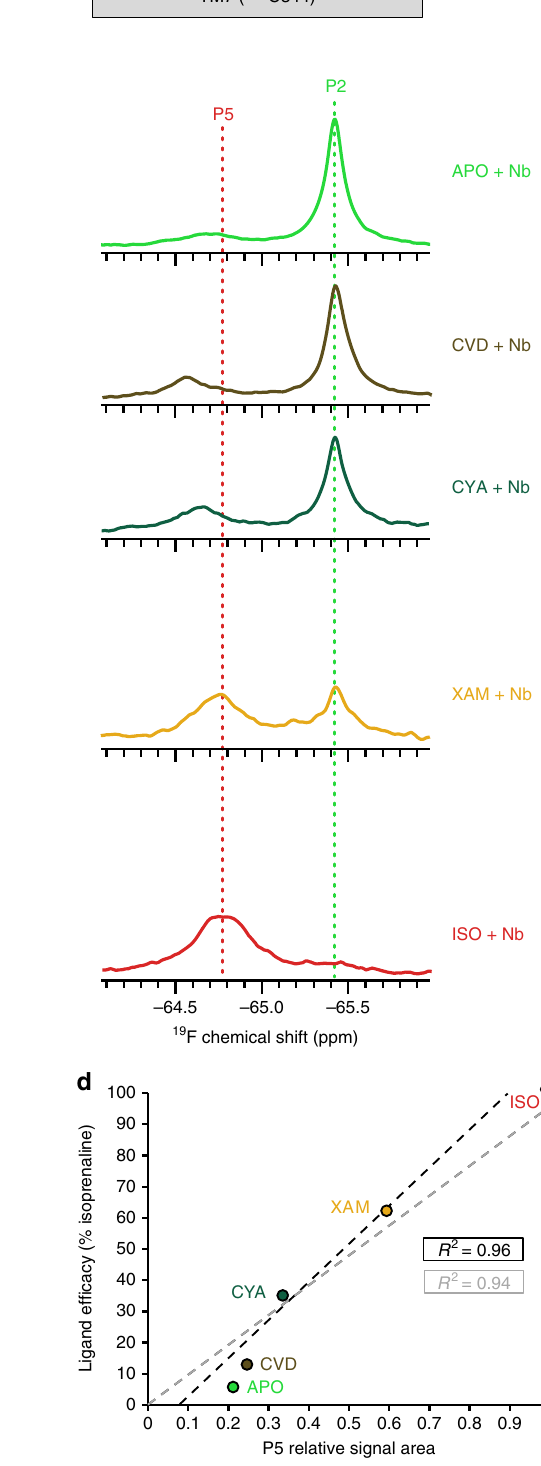
Probing the receptor with a range of agonists varying in ef fi - cacy revealed that the P1 signal for A282C TET, 6.27 showed only a relatively small response to ligand binding (Supplementary Note 3, Fig. 2a, Supplementary Figs. 6a, 12, 13). In contrast, while the TM7 signal P2 of TET C344 7.54 indicated the apo receptor residing in an inactive form (I 1 ), the signal P2 gradually moved further up fi eld with increasing ef fi cacy of the